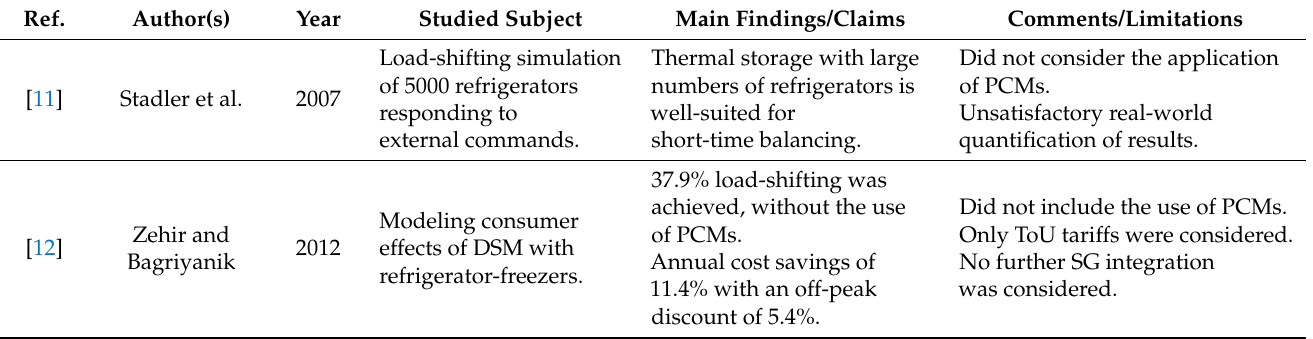
Table 2. Most relevant results from studies on load-shifting with domestic